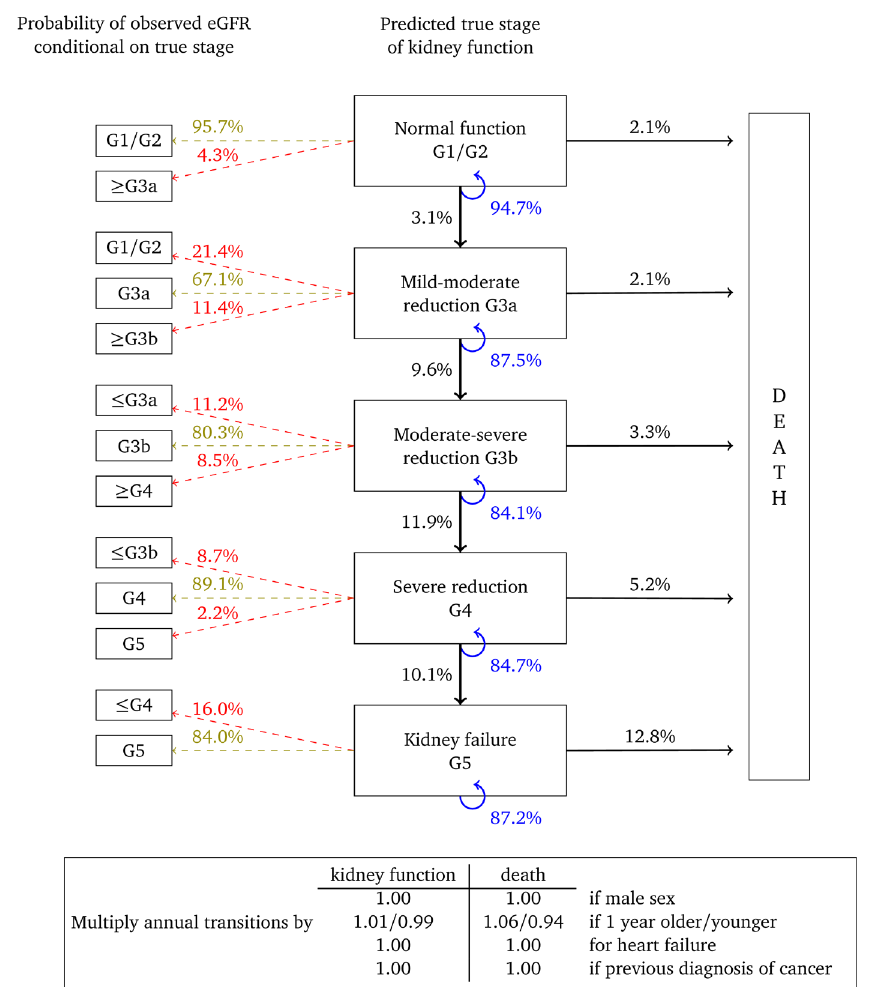
Figure 5. Annual transition model diagram for patients with macroalbuminuria at baseline. Probabilities are based on a woman aged 60, without heart failure or a previous diagnosis of cancer.